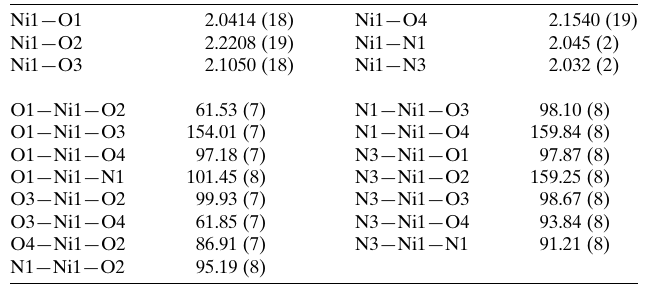
Table 1 Selected geometric parameters (A˚ , (cid:3) ).